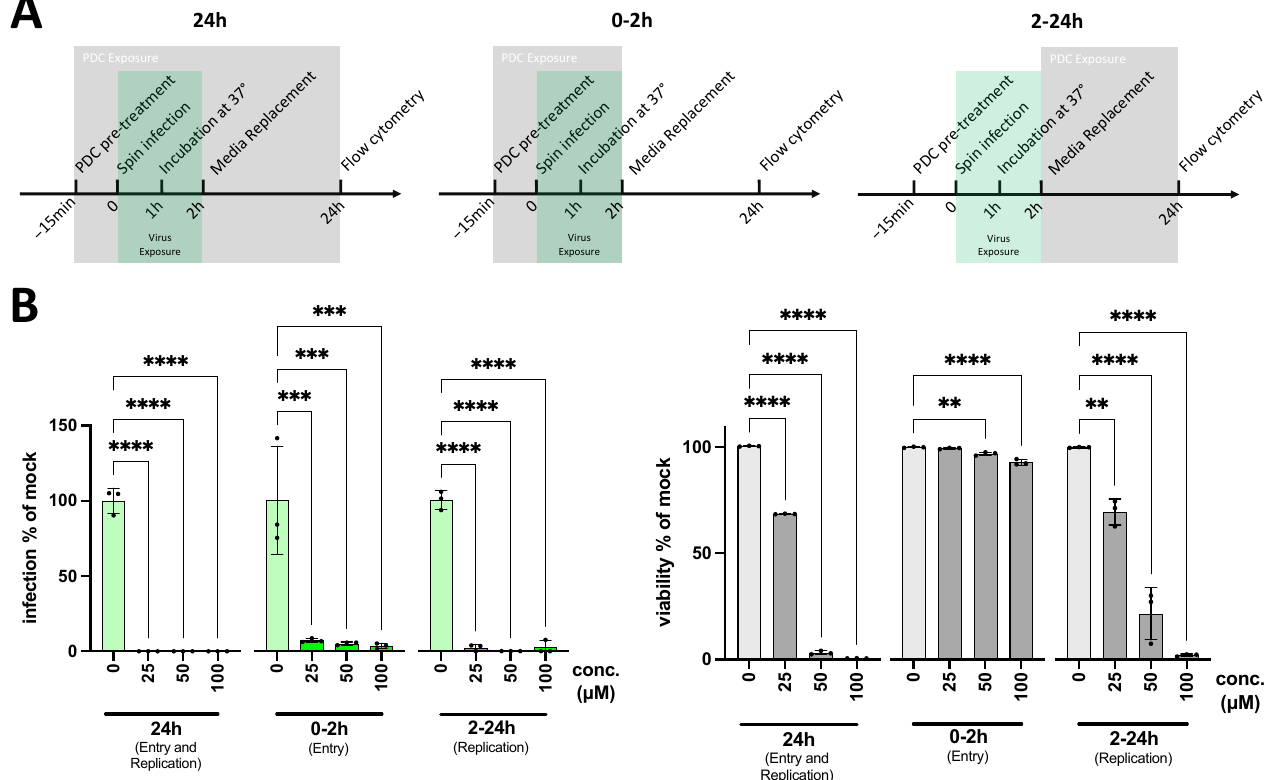
Figure 2. PDC-109 effects on virus entry and replication. ( A ) Experimental workflow for time-of- addition assay. Calu6 ACE2 cells were exposed to various concentrations of PDC at different phases of infection. The 24 h samples were incubated with PDC (grey box) for the entire infection period (green box), thus blocking virus entry and reporter virus infection. The 0–2 h samples were incubated with PDC-109 for the initial 2 h of infection only, limiting direct antiviral effects predominantly to the entry stage of infection. 2–24 h samples were treated with PDC at 2 h post-infection and, therefore, after successful viral entry. ( B ) Infection and viability were assessed by flow cytometry at 24 h post-infection. Frequencies of GFP+ cells are shown as a measure of VSV*SARS CoV-2 infection and were normalized to mock-treated samples (0 µ M). Labels indicate PDC-109 concentration in µ M. Significance was assessed by parametric one-way analysis of variance (ANOVA) tests, comparing all samples with the mock control (0 µ M) and displayed as follows: **** p < 0.0001; *** p < 0.001; ** p = 0.001–0.01; * p = 0.01–0.05. IC50 and CC50 values as well as the selective index, can be found in SI Table